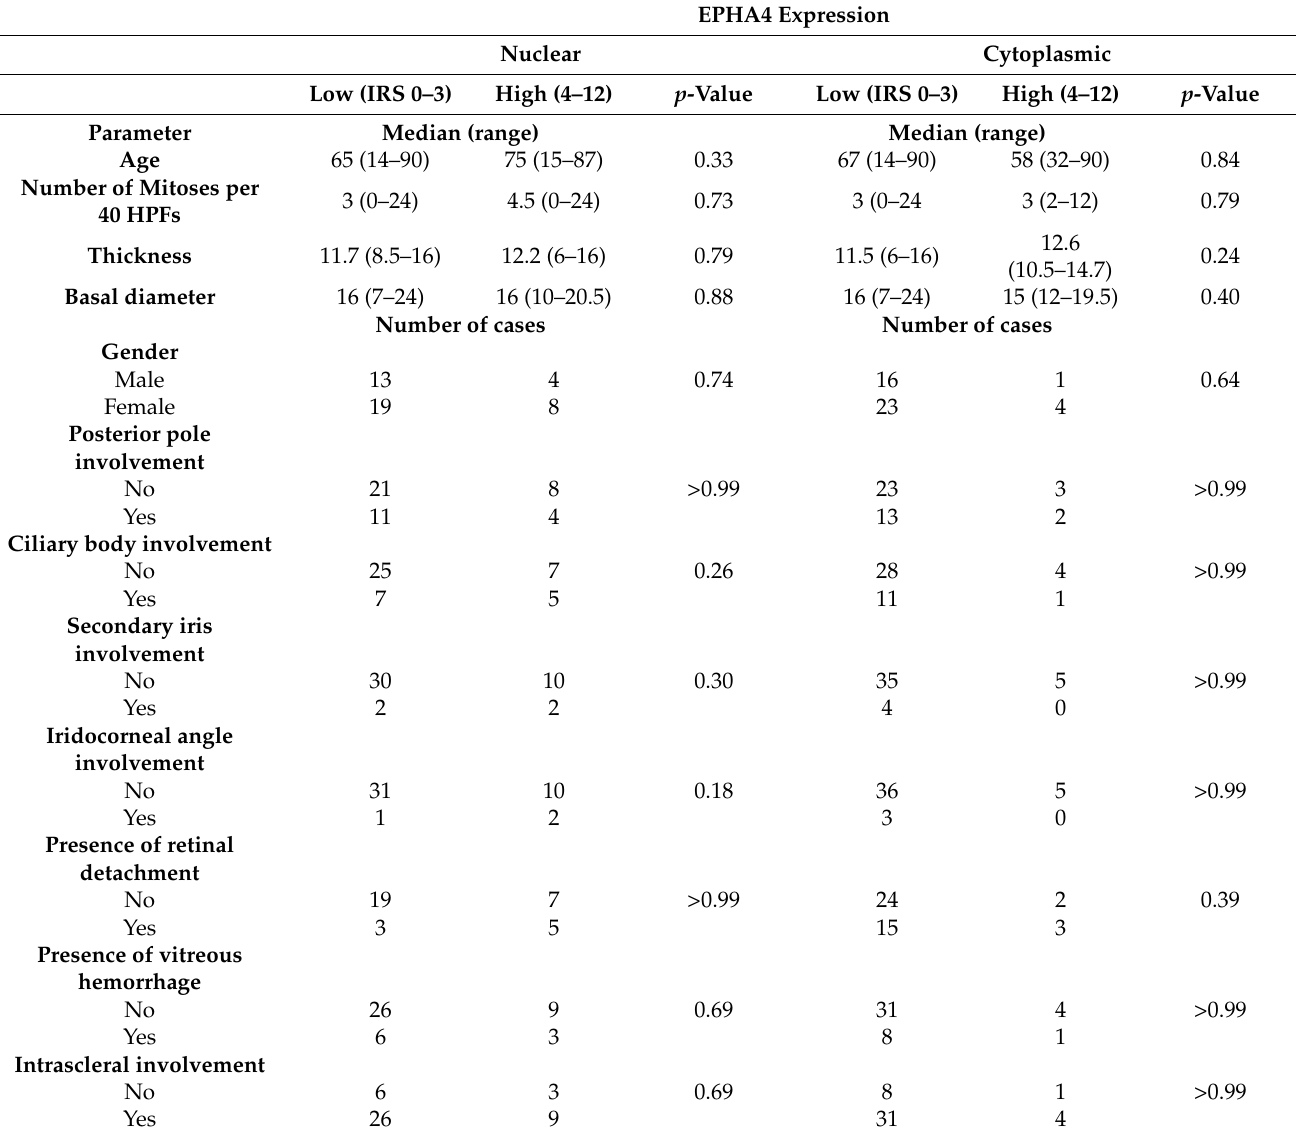
Table 3. Associations of nuclear and cytoplasmic EPHA4 with clinicopathological